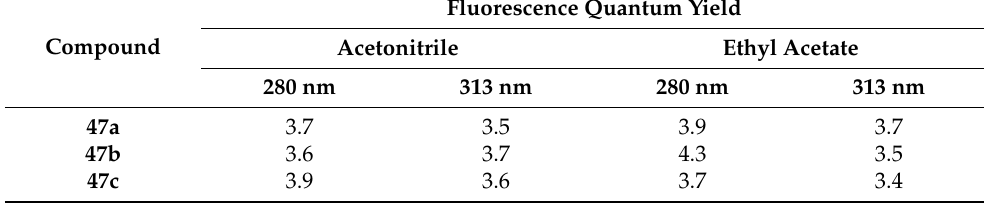
Table 8. Fluorescence quantum yield ( Φ fl ) of the chromeno [2,3- b ]indole derivatives 47a – c in acetoni- trile and ethyl acetate at 280 nm (tryptophan in water as reference) and at 313 nm (naphthalene in ethanol as